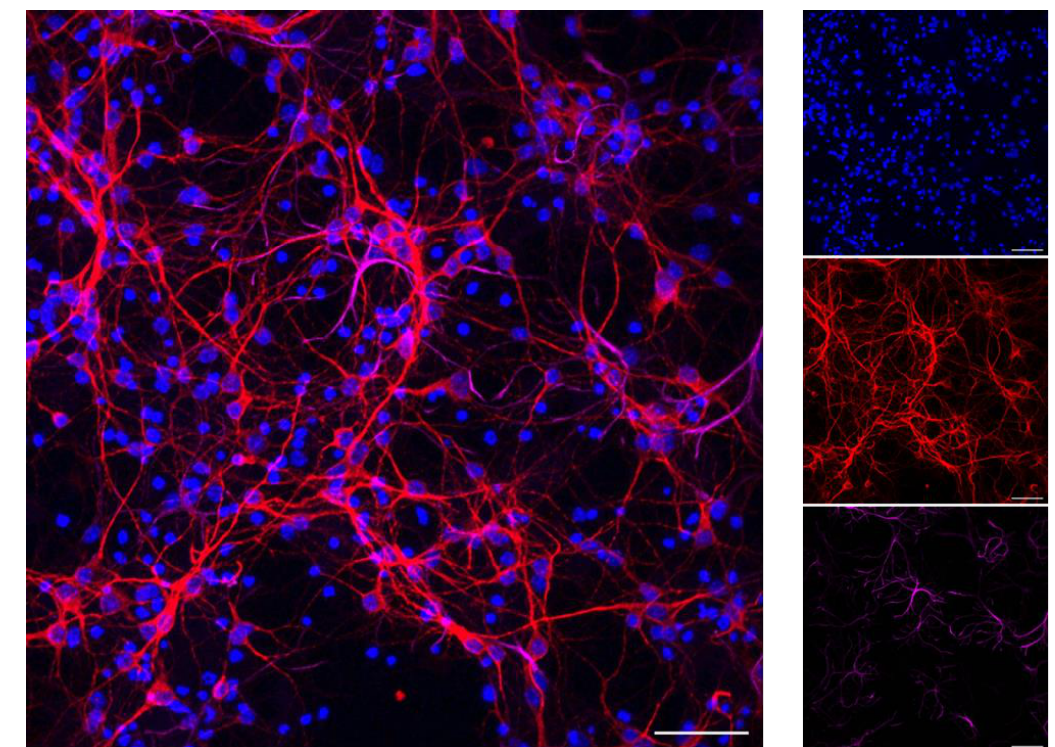
Figure 6. Representative images of primary mouse cortical cells maintained in culture for 7 DIV and immunolabelled for nuclear marker DAPI (blue), neuronal marker MAP2 (magenta), and astrocytic marker GFAP (magenta). The majority of cells in primary cultures were positive for MAP2 and, to a lesser degree, for GFAP. Scale bar: 50 µm. Gene expression analysis confirmed that Atg16L1 was significantly increased in cul- tures from transgenic mice when insulin resistance was induced (Table 2), whereas no other difference was detected in the other genes analysed. In addition, Gabarap showed a significant reduction by genotype (Table 2). However, the findings showed a very high level of variability within groups. Table 2. mRNA levels of Atg16L1 , Atg16L2 , Gabarap , GabarapL1 , GabarapL2 , and Sqstm1 in neuronal primary cultures obtained from wild-type or 3xTg-AD mice. Cells received insulin treatment (ins) at 100 nM for 30 min; glucose at 40 mM for 24 h followed by 100 nM insulin for 30 min (glu + ins); insulin at 20 nM for 24 h followed by 100 nM insulin 30 min (ins + ins); or vehicle (ctr). The means ± SEM are reported. *: p < 0.05 in the planned comparison vs. ctr; n = 3/group. Wild-Type 3xTg-AD ctr Wild-Type